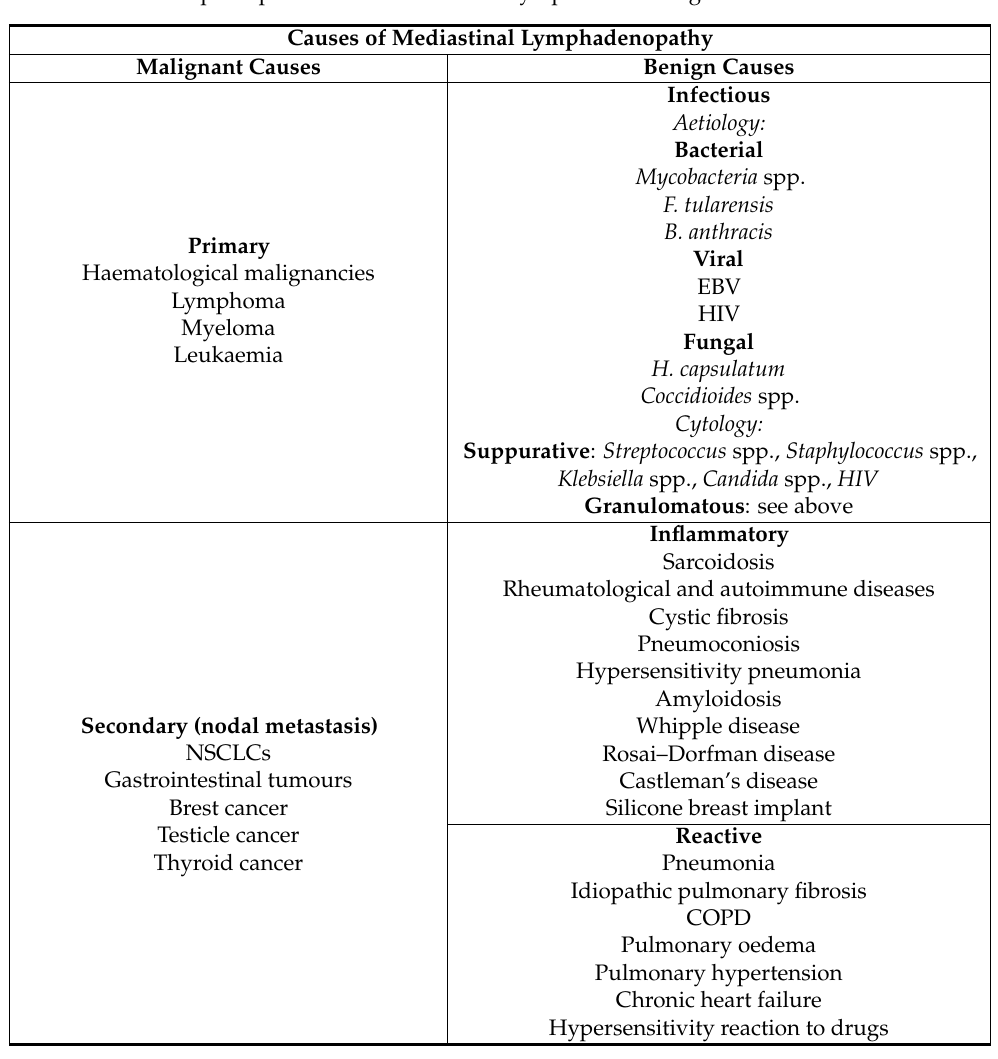
Table 1. Scheme of principal causes of mediastinal lymph node